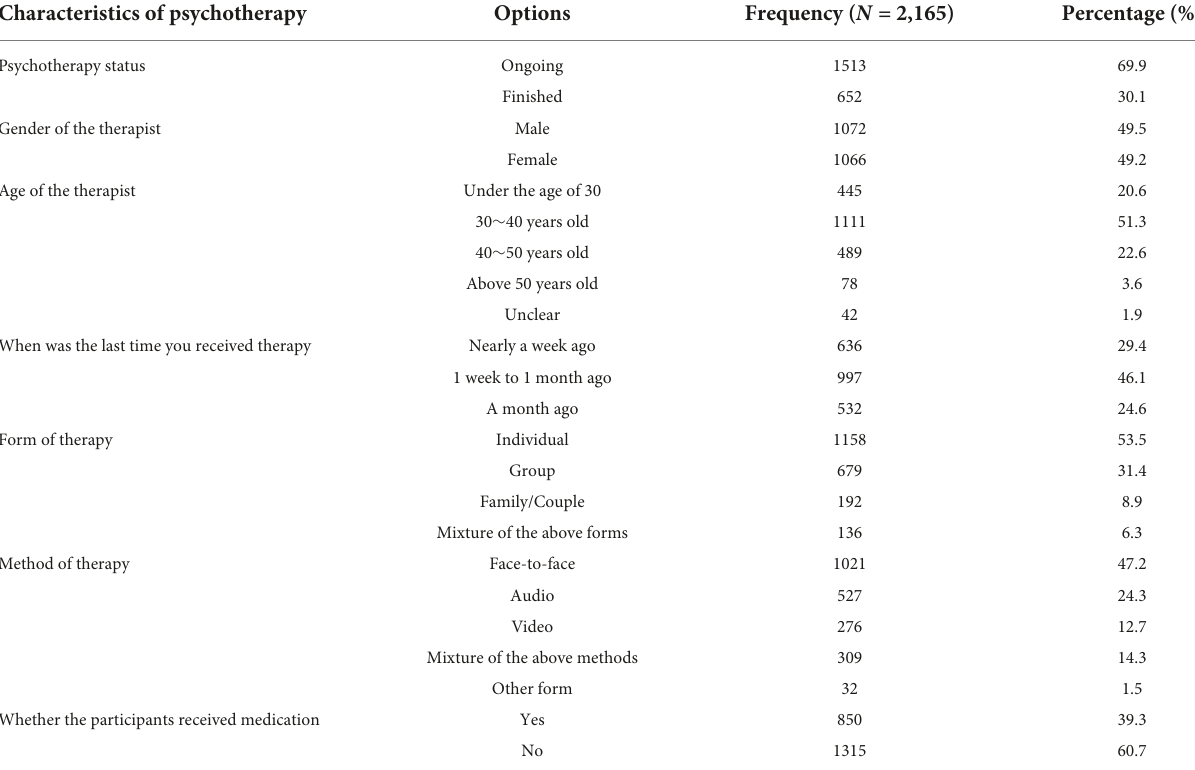
TABLE 1 Background information of participants’ participation in psychotherapy in sample 1. Characteristics of